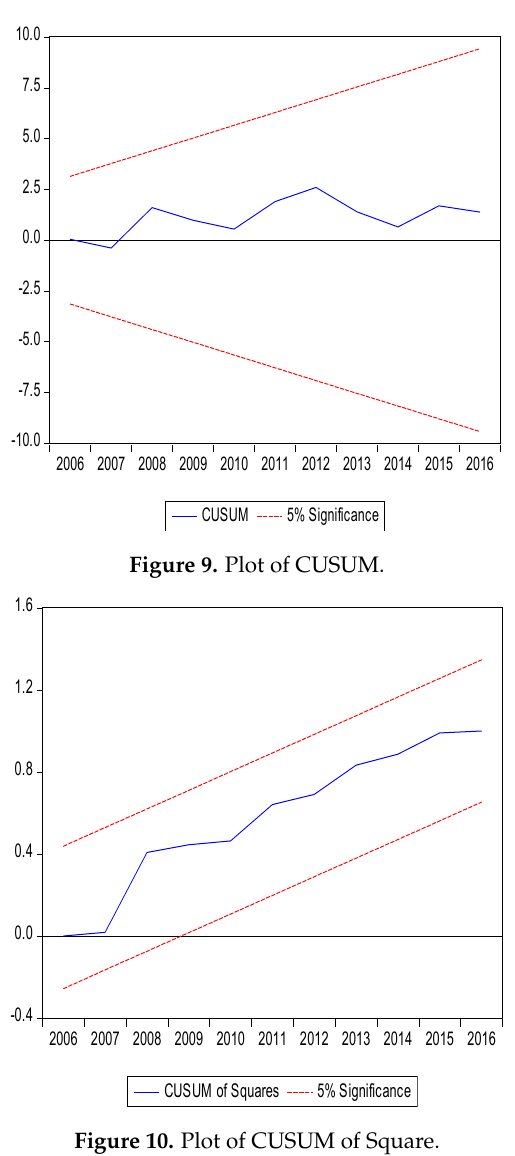
Figure 10. Plot of CUSUM of Square.